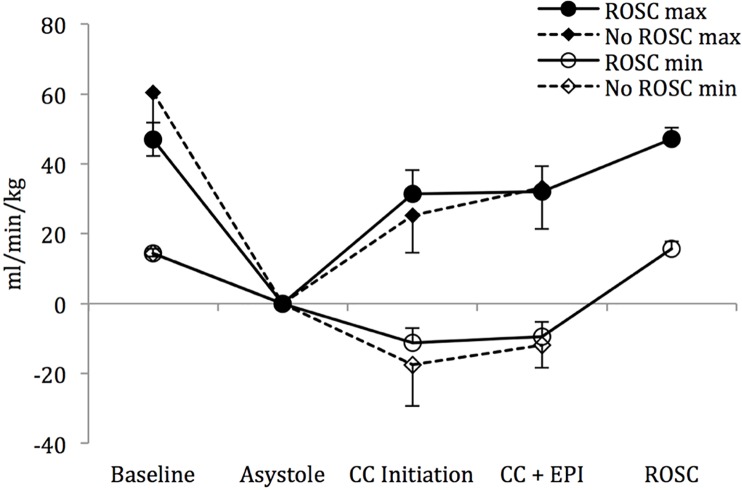
Left carotid artery flow.Maximum left carotid flow increases with initiation of chest compressions in lambs with ROSC and no ROSC. During the relaxation phase of chest compressions (minimum flow), retrograde flow is observed in lambs of both groups. Flow becomes exclusively anterograde upon ROSC and cessation of chest compressions. Data are mean ± SEM bars.